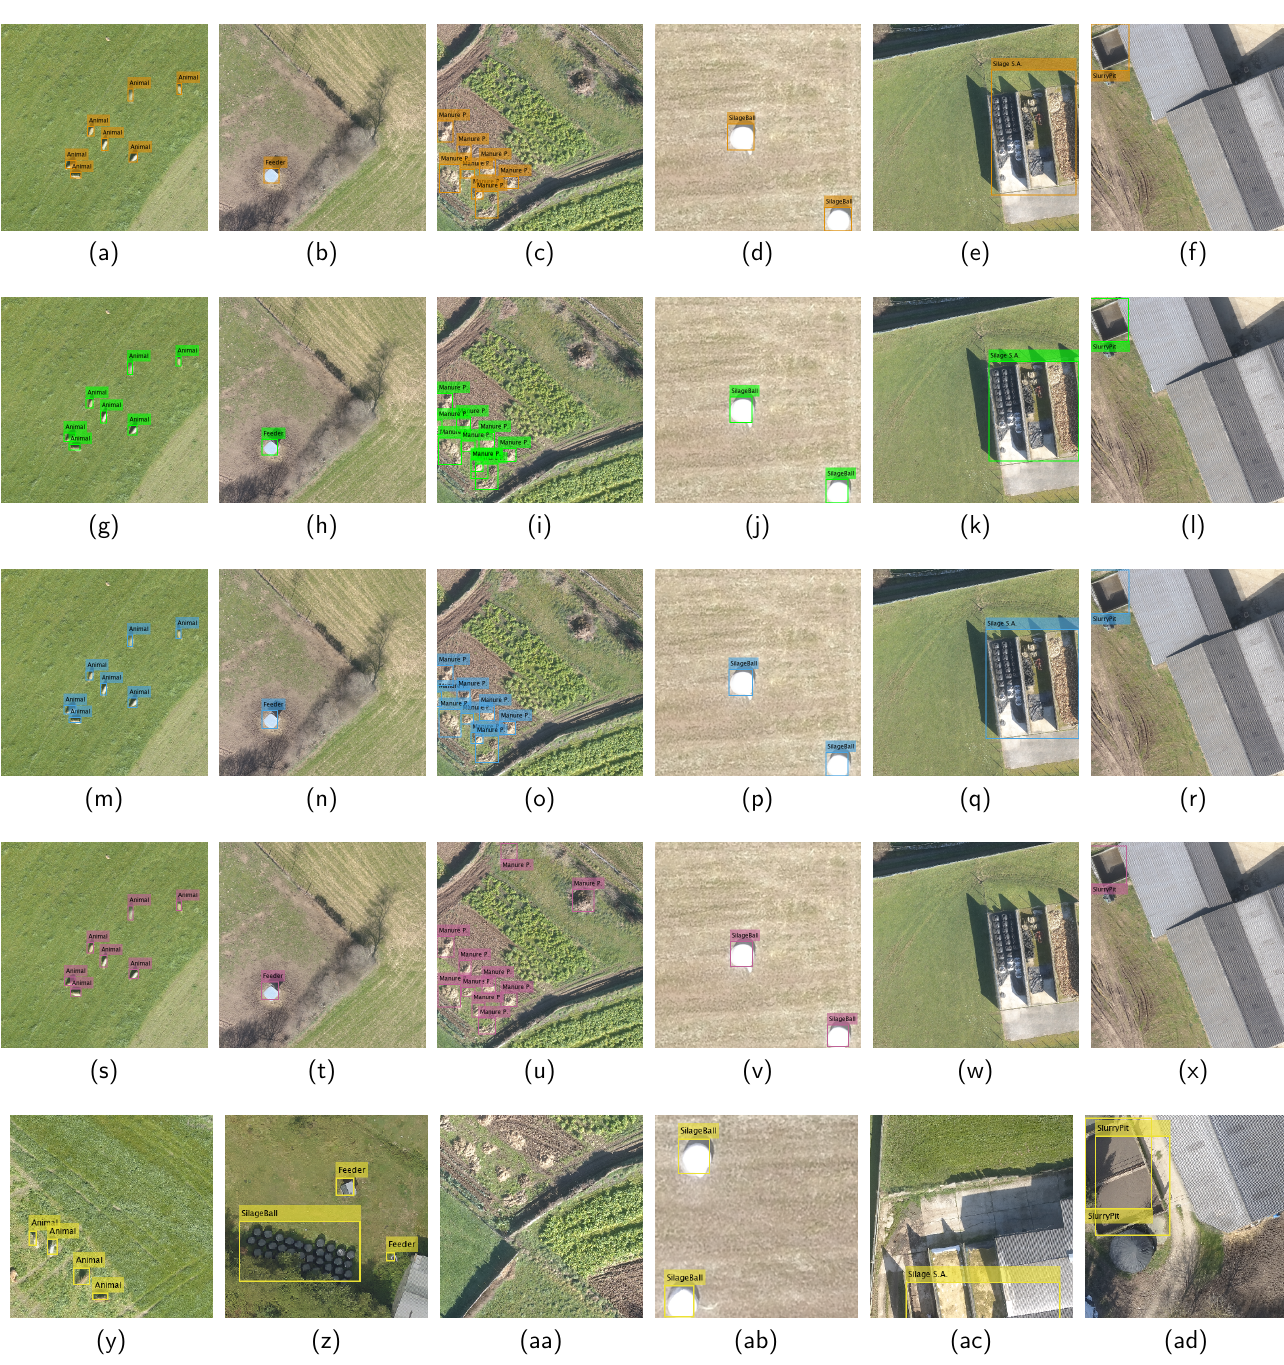
Figure 5. Comparison of detections performed on a subset of tests. ( a – f ) detections performed with YOLOv2; ( g – l ) detections performed with YOLOv4; ( m – r ) detections performed with YOLOv5; ( s – x ) detections performed with Azure Custom Vision; ( y – ad ) detections performed with SSD. The images used with SSD are not the same as those used with other detectors due to the input size